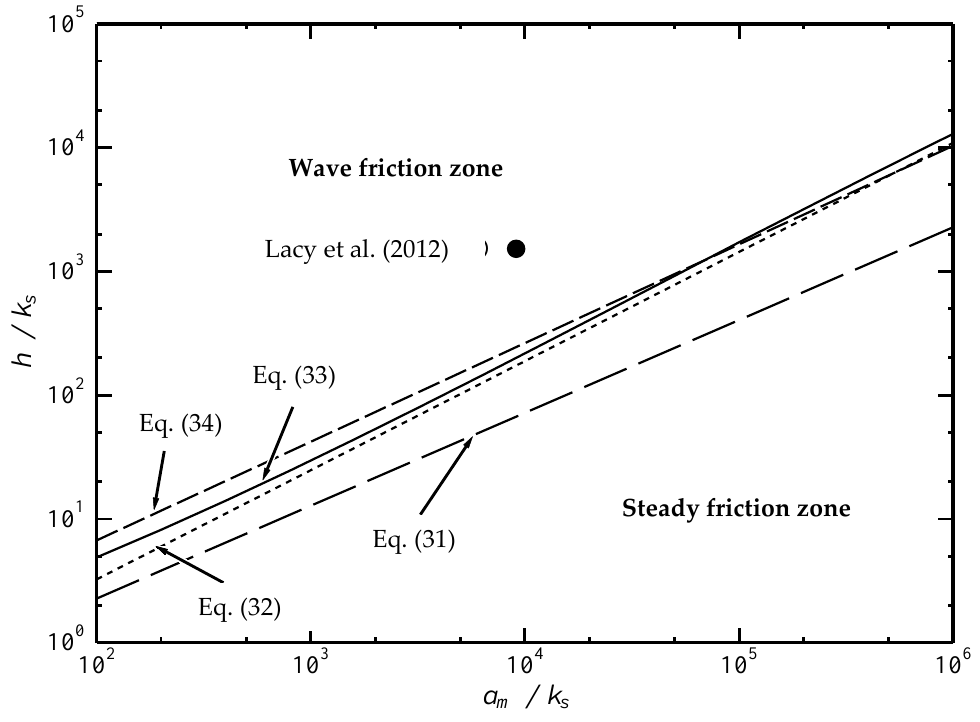
Figure 9. Demarcation criteria for wave friction zone and steady friction zone.